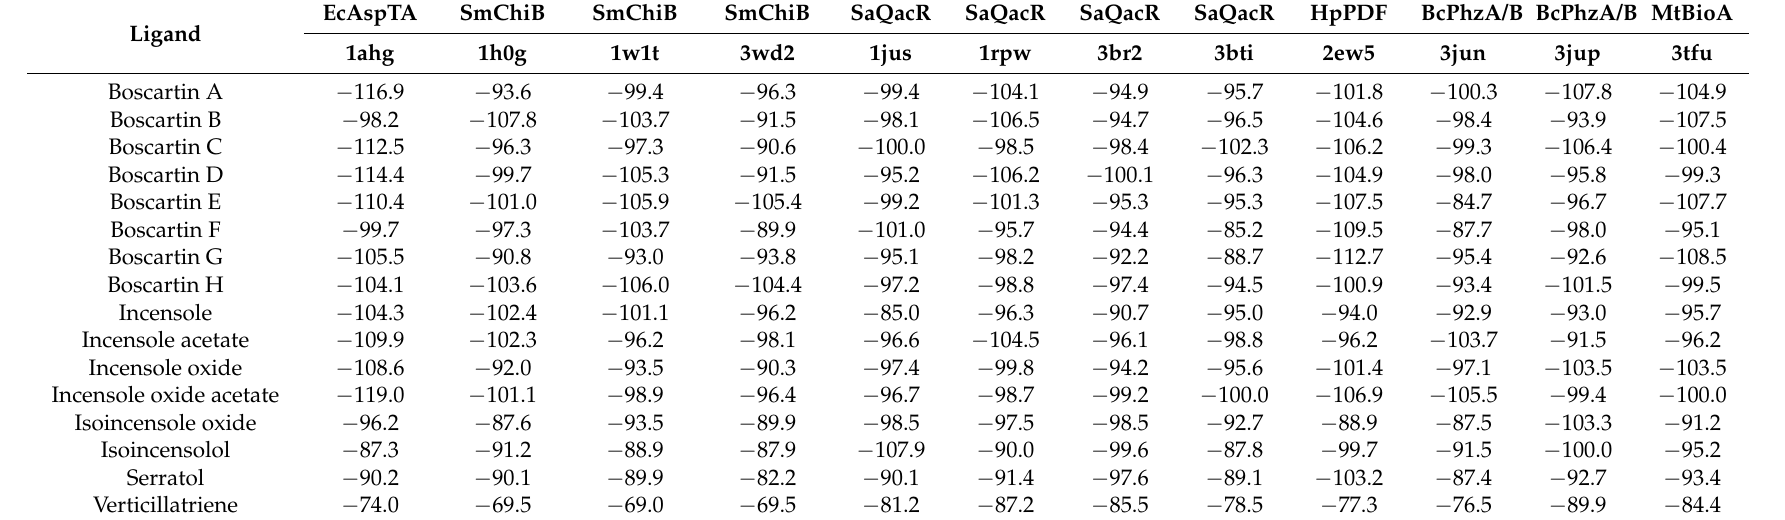
Table 3. MolDock molecular docking energies (kJ/mol) of Boswellia cembranoids with bacterial target proteins.